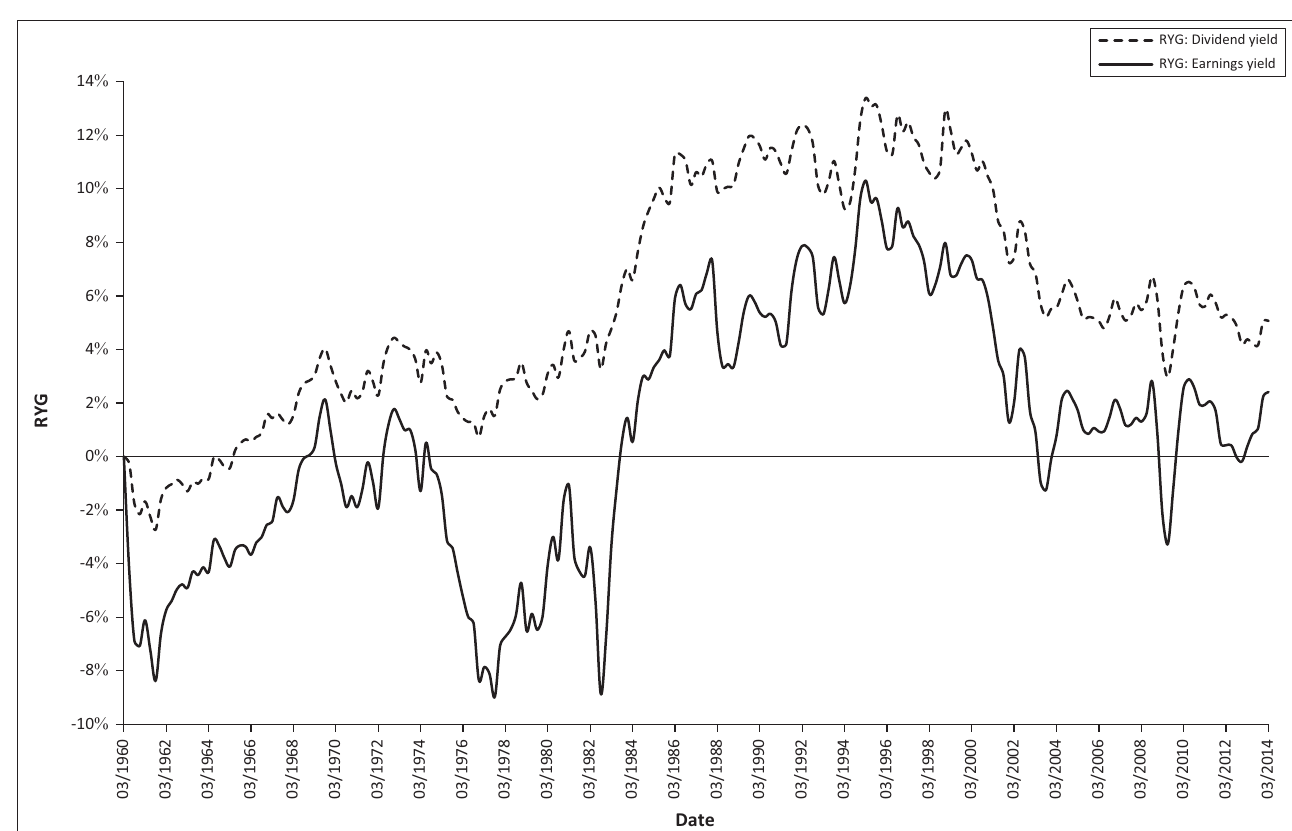
FIGURE 1: The reverse yield gap in South Africa from 1960 to